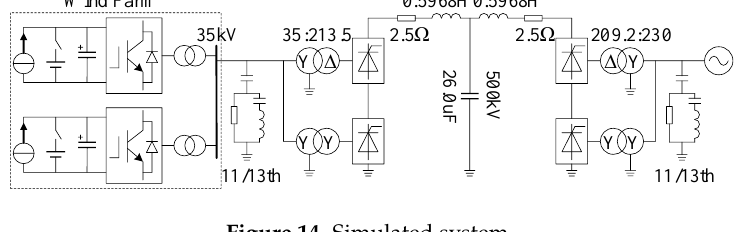
Figure 14. Simulated system. Table 1. Parameters of the simulated system.